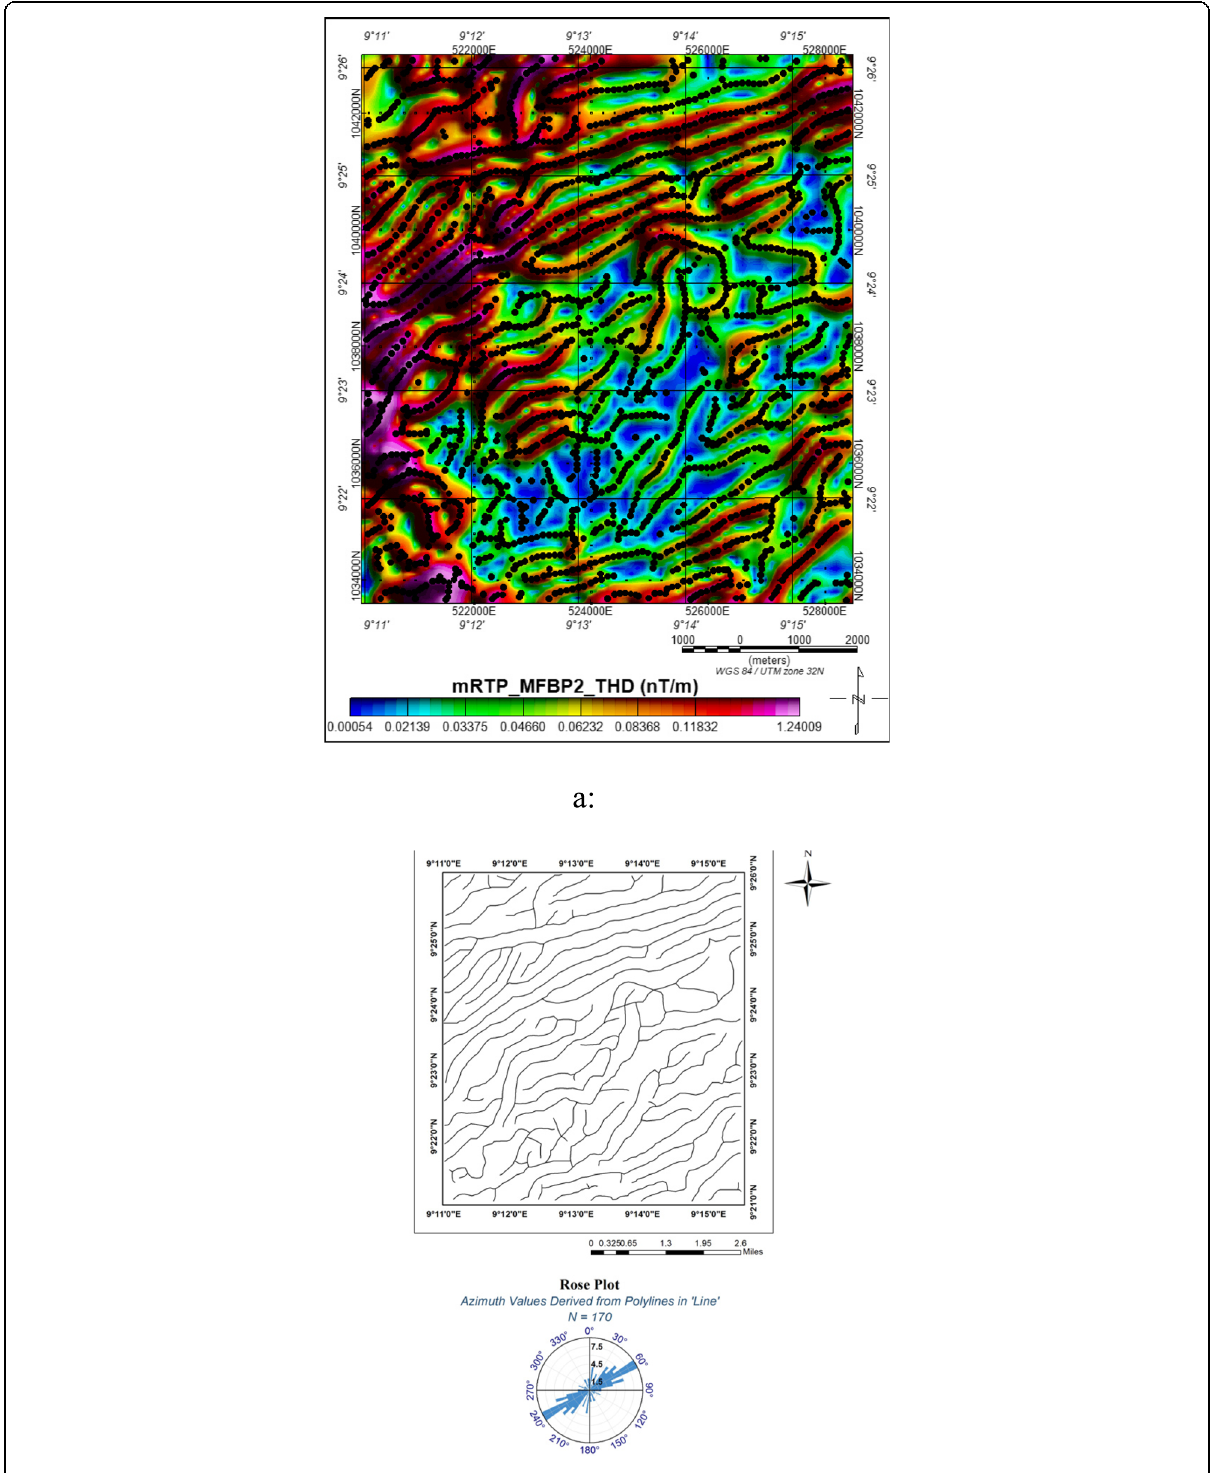
Fig. 23 a Edge enhanced total horizontal derivative of layer 2. b Linear/curvilinear map of layer